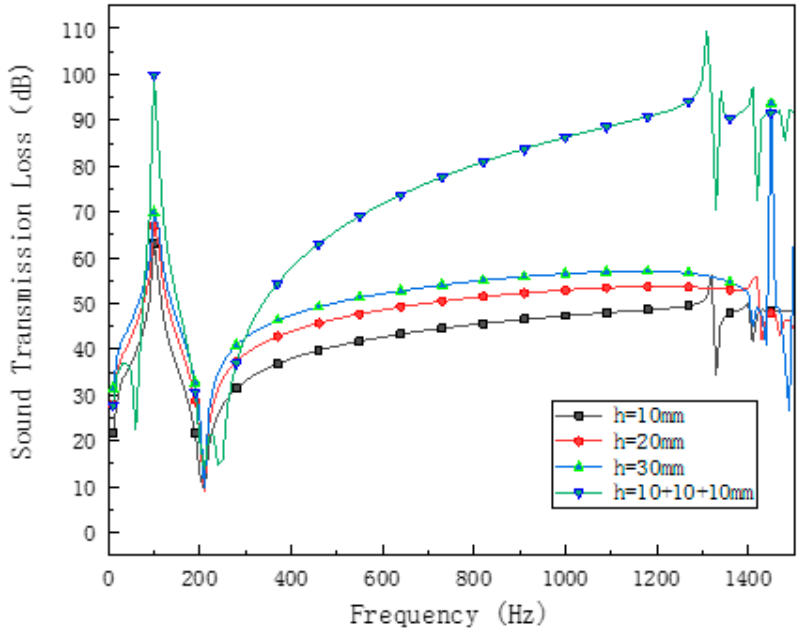
Figure 6. STL of phononic crystals cavity plates (h = 10 mm + 10 mm + 10 mm), homogeneous cavity plates, and phononic crystals plate with various thicknesses: h = 10 mm, h = 20 mm (the same mass with phononic crystals cavity plates), and h = 30 mm (the same volume with phononic crystals cavity plates). The peak and bottom values of all types of STL are the same, 100 and 210 Hz, respectively. This is highly consistent with the calculation result of the energy band, which proves the correctness of both.